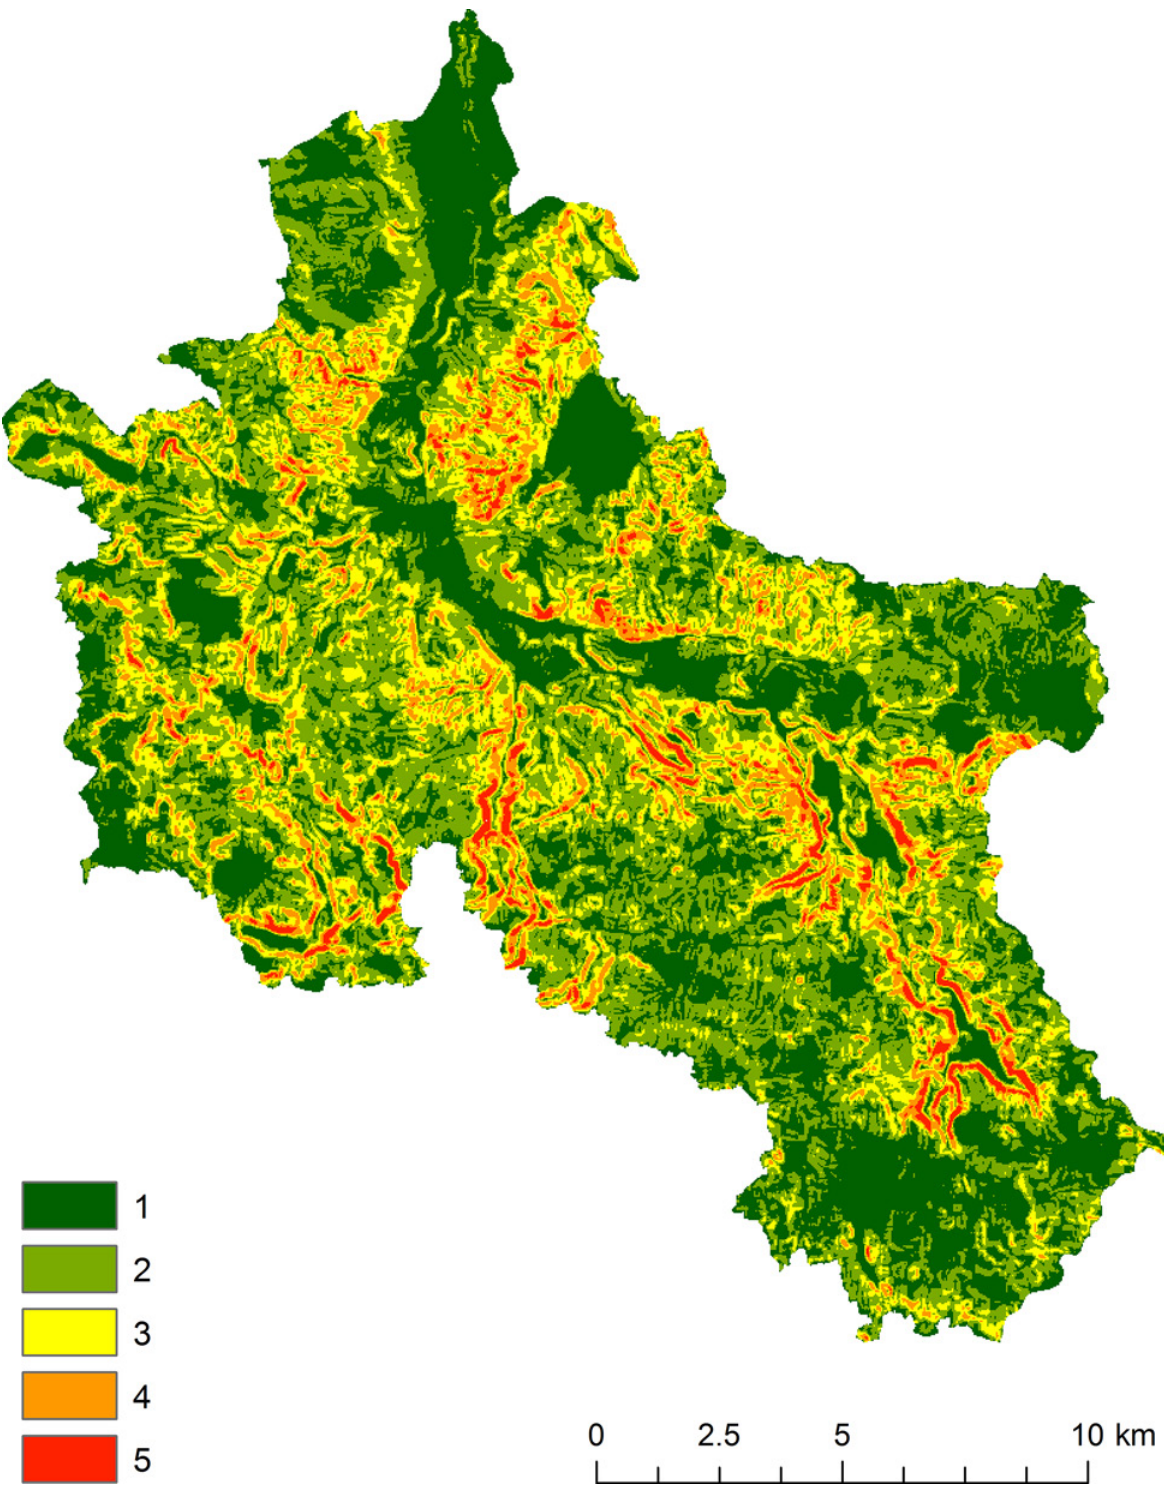
Fig. 4. Factor map of the relative height